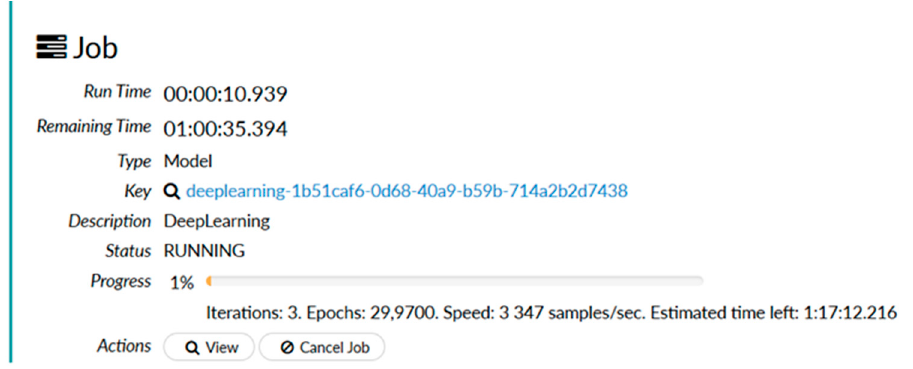
Figure 3. Screenshot from H 2 O application during model generation.